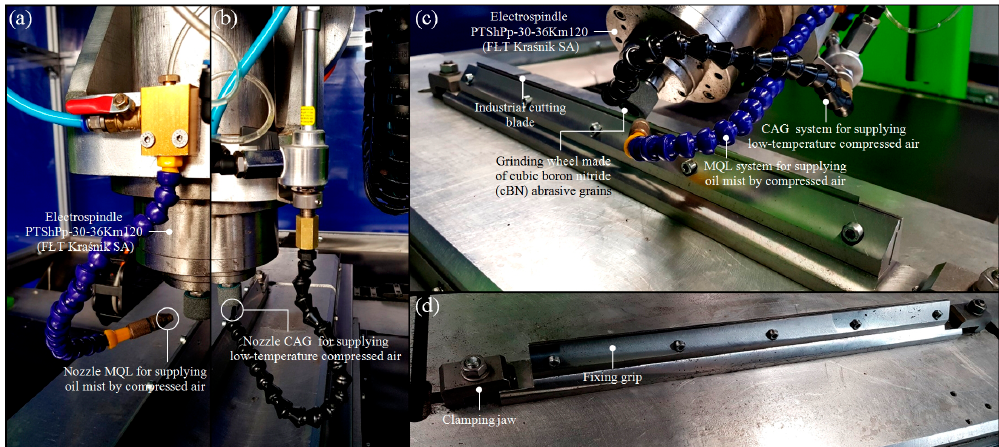
Figure 4. Construction phase of a 5-axis CNC grinding machine for the precision grinding process of the cutting edges of industrial cutting blades: ( a ) Cooling–lubricating system based on the minimum quantity lubrication (MQL) method, using nozzle MQL for supplying oil mist by compressed air; ( b ) cooling–lubricating system based on the cold air gun (CAG) method, using nozzle CAG for supplying low-temperature compressed air; ( c ) fixing grip with mounted industrial cutting blade during regeneration process; ( d ) details of fixing grip.